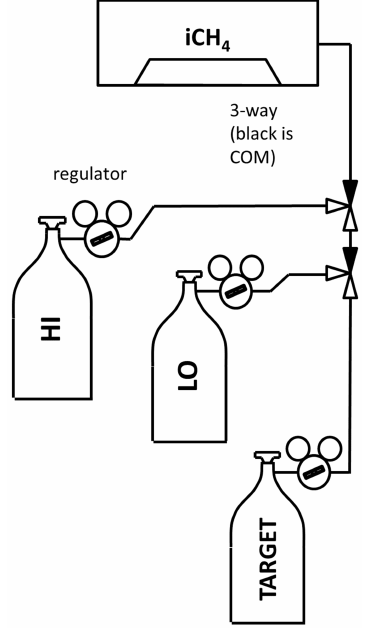
Figure 6. Setup for drift correction